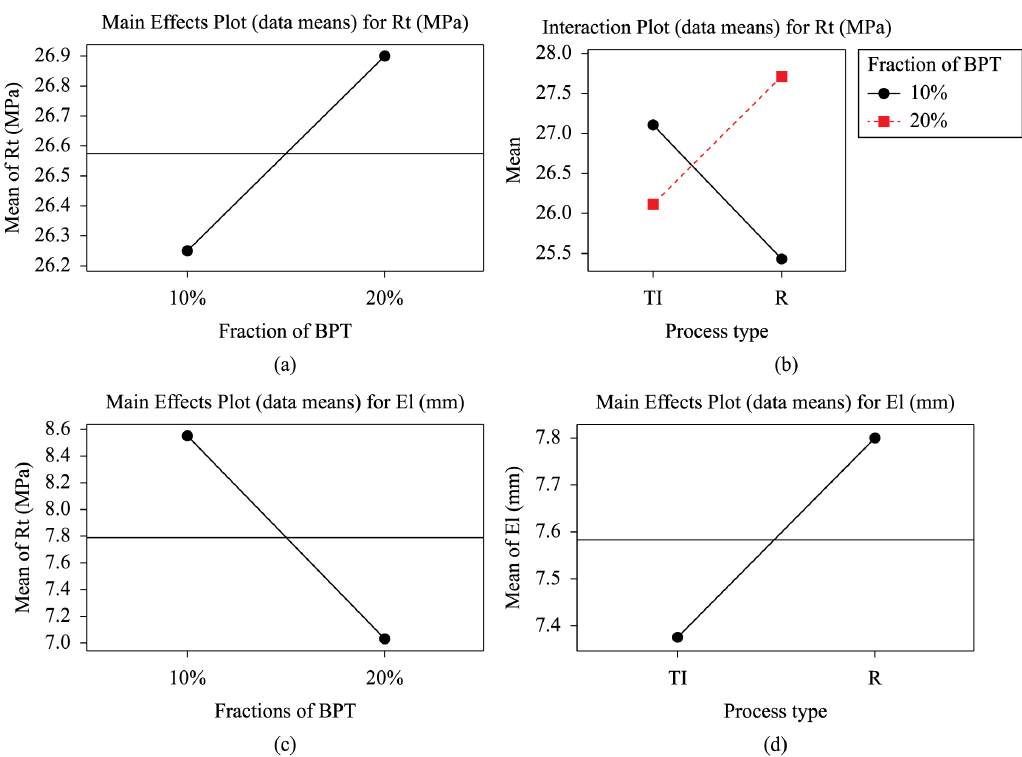
Figure 2. Major factors and their interactions (BPT) for (a, b) tensile strength and (b, c) maximum tensile strain through elongation.